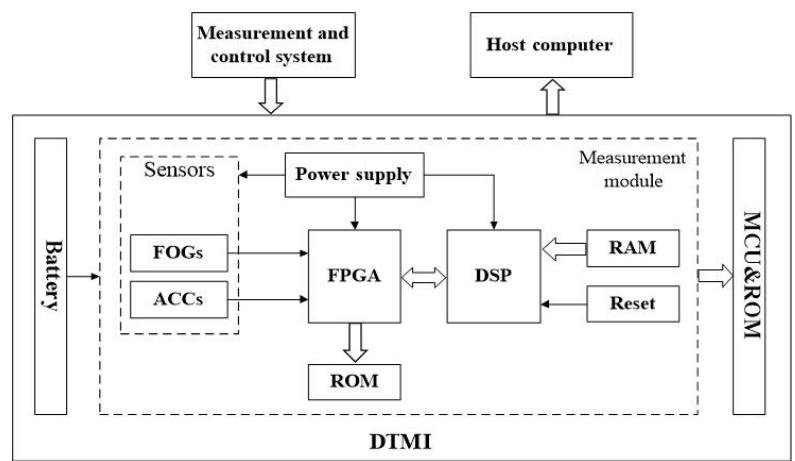
Figure 4. Hardware diagram of